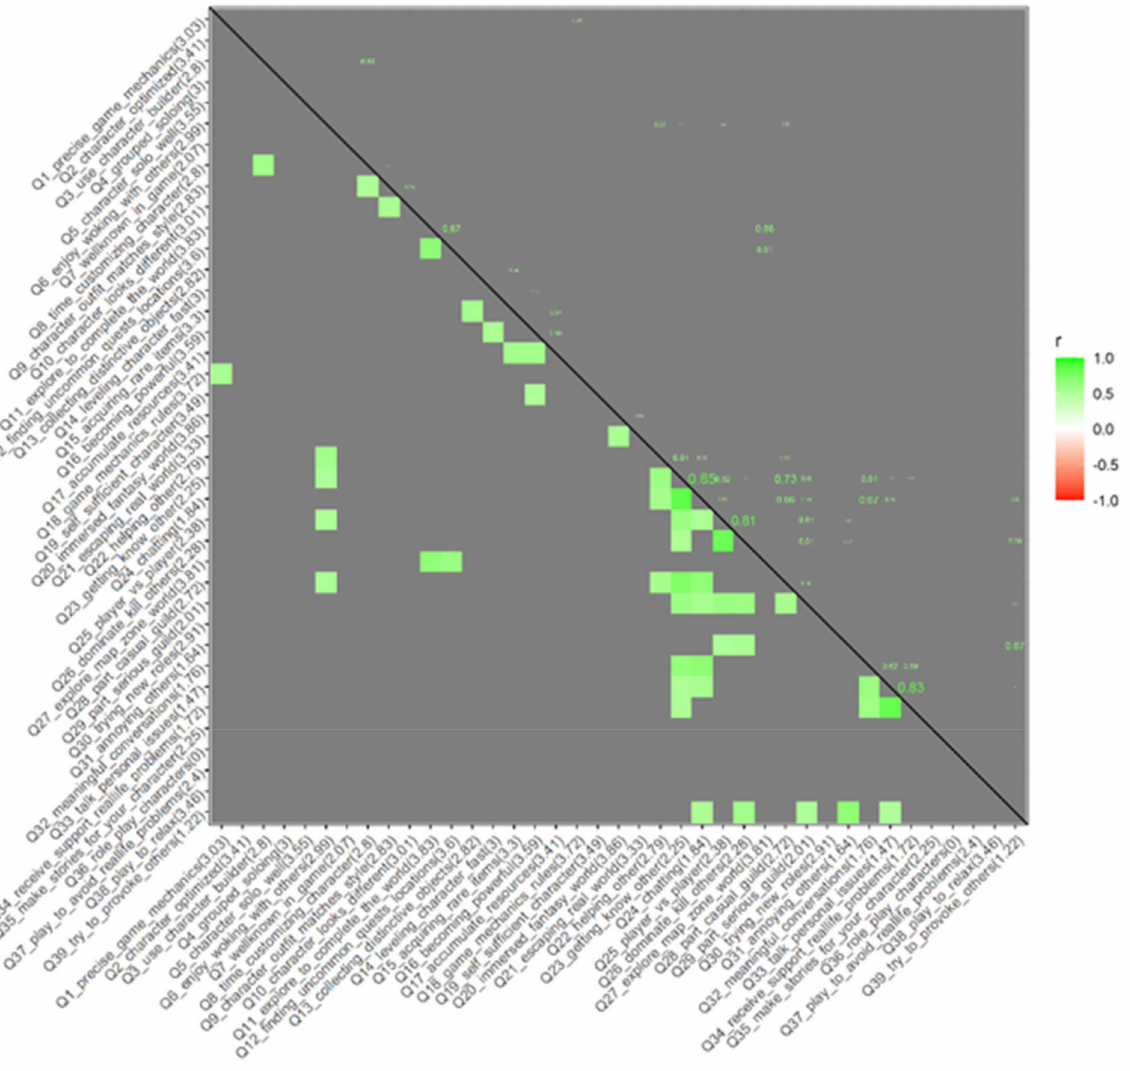
Figure 6. Correlations (r) greater than 0.5 in a matrix. Correlation indicated with colors under the diagonal and in numbers above the